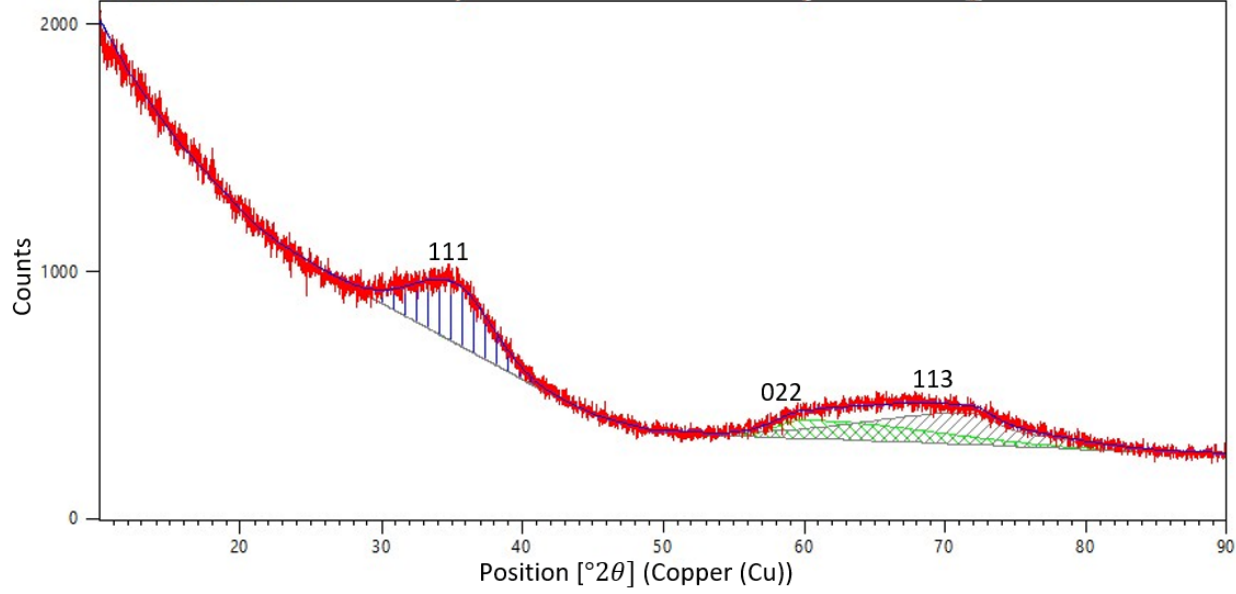
Figure 13. Diffraction pattern of the organomorphic SiC-preform (wide peak analysis was performed using the specialized HighScore Plus software for phase analysis).